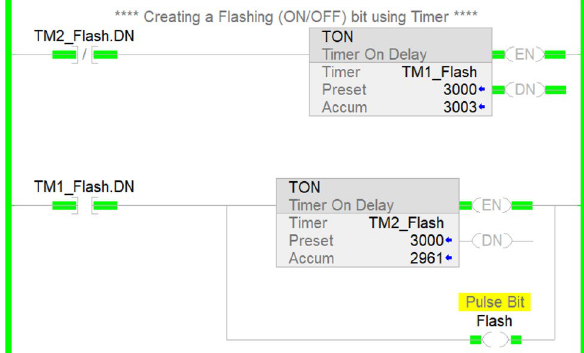
Fig. 11 Create a flashing bit using timer on delay